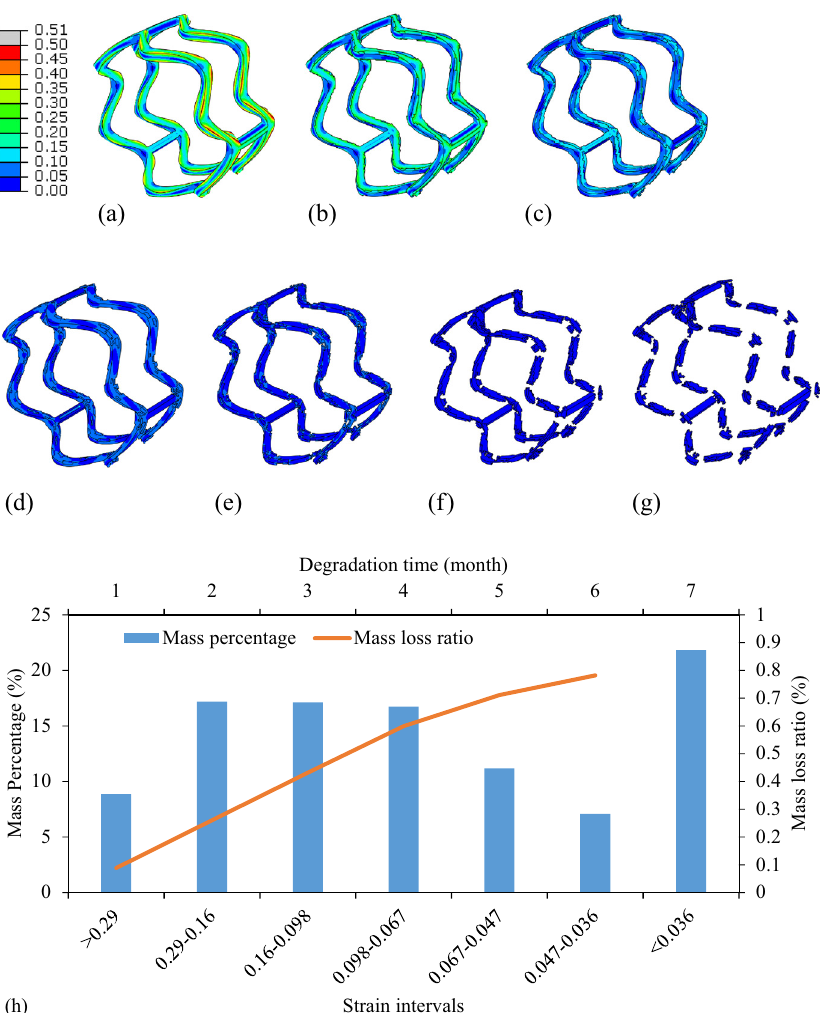
Figure 5: Contour of maximum principal strain at ( a ) 0 month, ( b ) fi rst month, ( c ) second month, ( d ) third month, ( e ) fourth month, ( f ) fi fth month, and ( g ) sixth month. ( h ) Strain histogram and the mass loss ratio of the